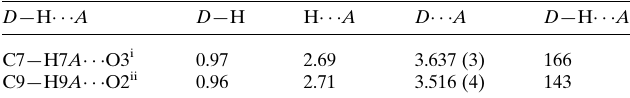
Table 1 Hydrogen-bond geometry (A˚ , (cid:4) ).